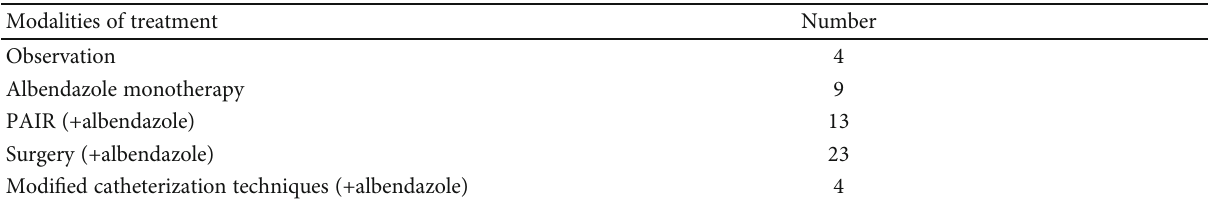
Table 5: Modalities of